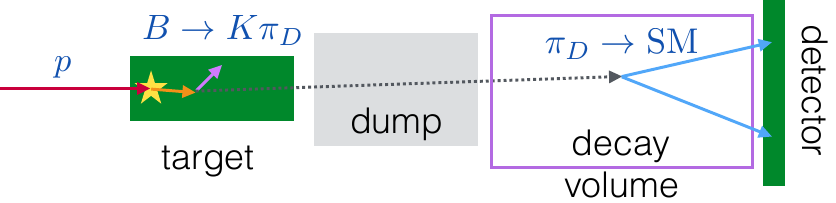
Figure 9. Schematic view of dark pion production and decay in a (cid:12)xed target experiment. A 400 GeV proton has a probability of 1 : 6 10 (cid:0) 7 to produce a pair of b -quarks [74] when scattering (cid:2) o(cid:11) the target. With 10 20 (10 18 ) protons on target, up to 10 8 (10 6 ) dark pions can be produced from B meson decays in the SHiP and NA62 experiments,